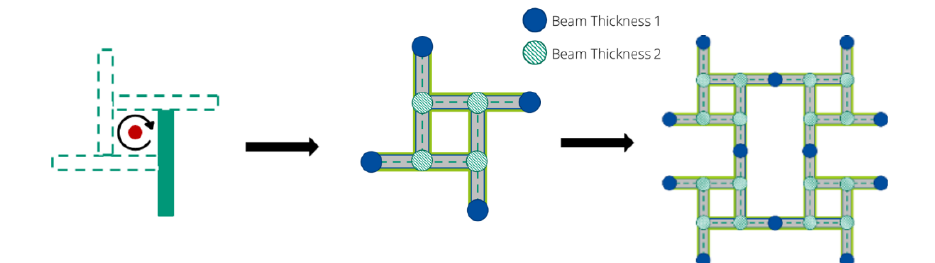
Fig. 5. Antitetrachiral structure, starting with the rotational symmetry of the smallest component, resulting in the unit cell with sets of nodes with the same properties, reducing the number of total parameters for the whole structure. Unit cell is mirrored in two directions in space creating the antitetrachiral structure. The number of parameters stays the